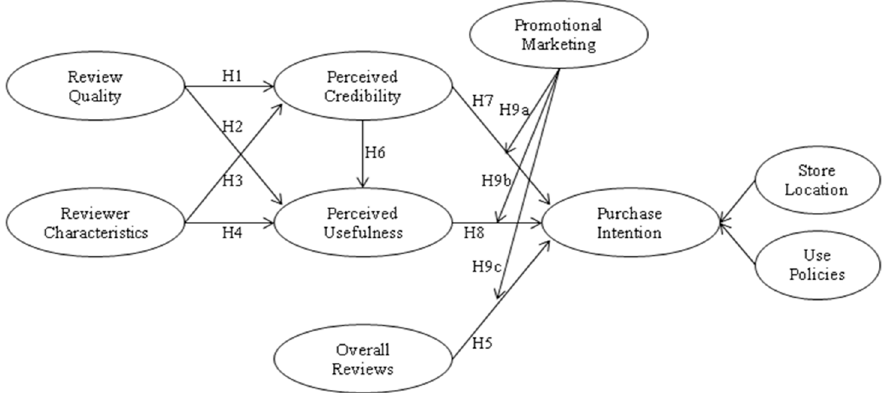
Figure 1. Theoretical framework.